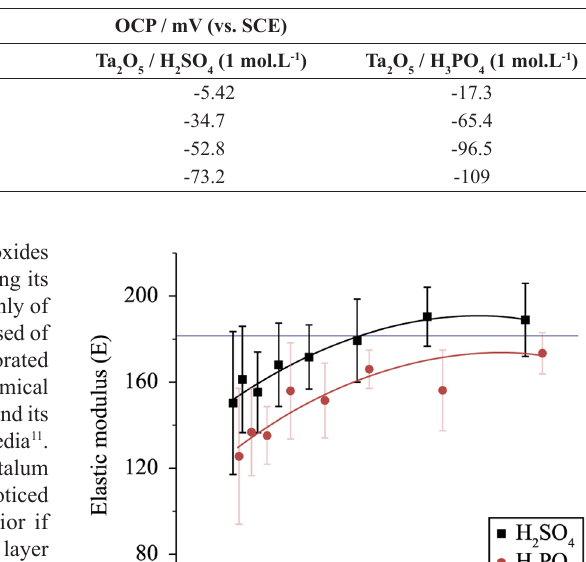
SO and H PO (1 mol.L -1 ) before and after immersion in artificial 2 4 3 4